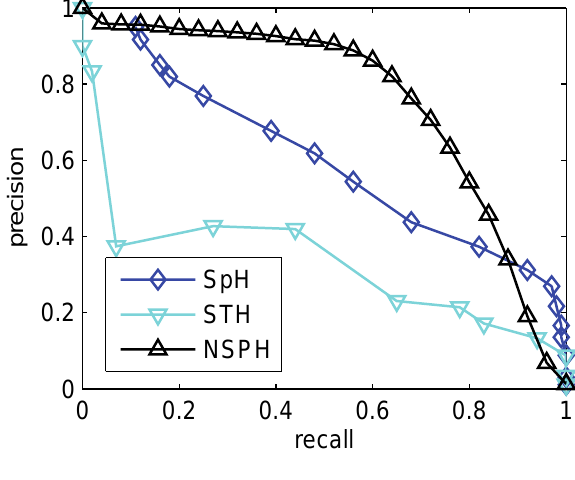
Fig. 5. Precision-Recall curve of the comparative hashing